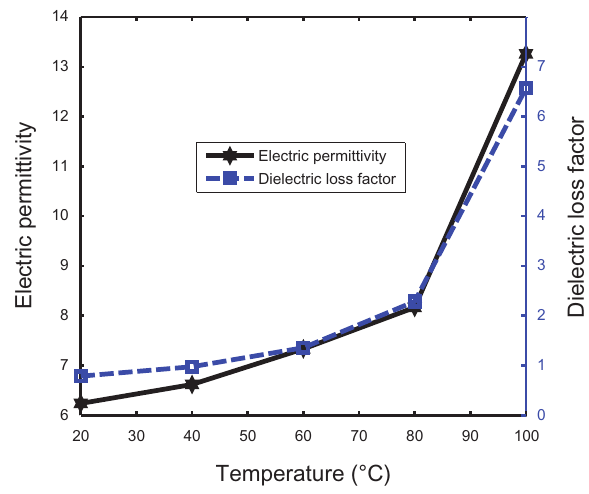
Figure 4: The mutual coupling between the position of material along X axis and along Y axis at 2.45GHz.